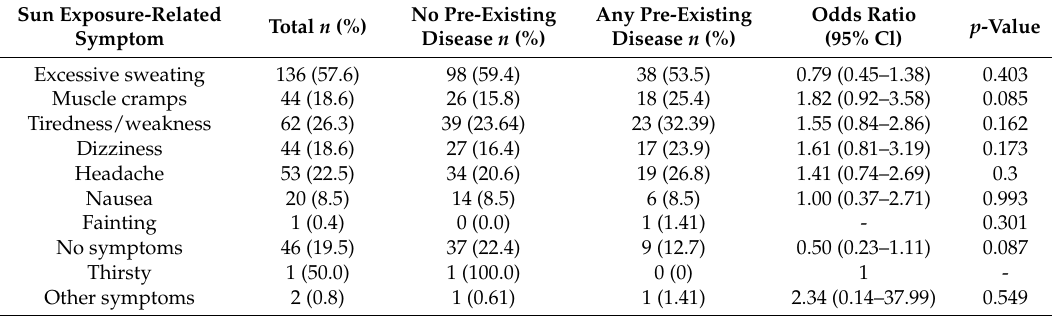
Table 3. The relationship between the experience of sun exposure-related symptoms and pre-existing diseases among the study participants. None of the odds ratios were statistically significant.